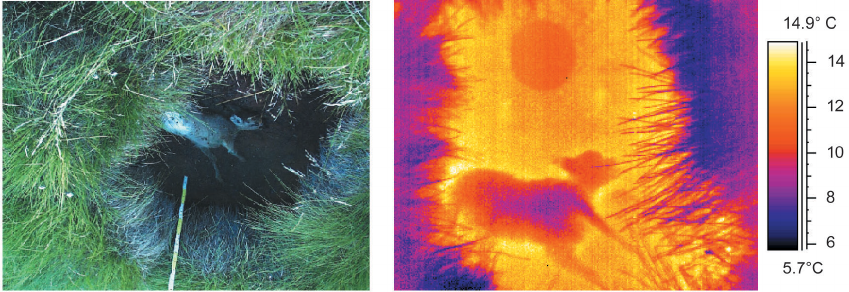
Fig. 14. Photo and thermal image of suffocated fawn in an approximately 80 cm deep mofette at Bublak, Czech Republic. The circular warm structure above the fawn is an infrared reference radiator that has not quite adapt- ed the mofette soil